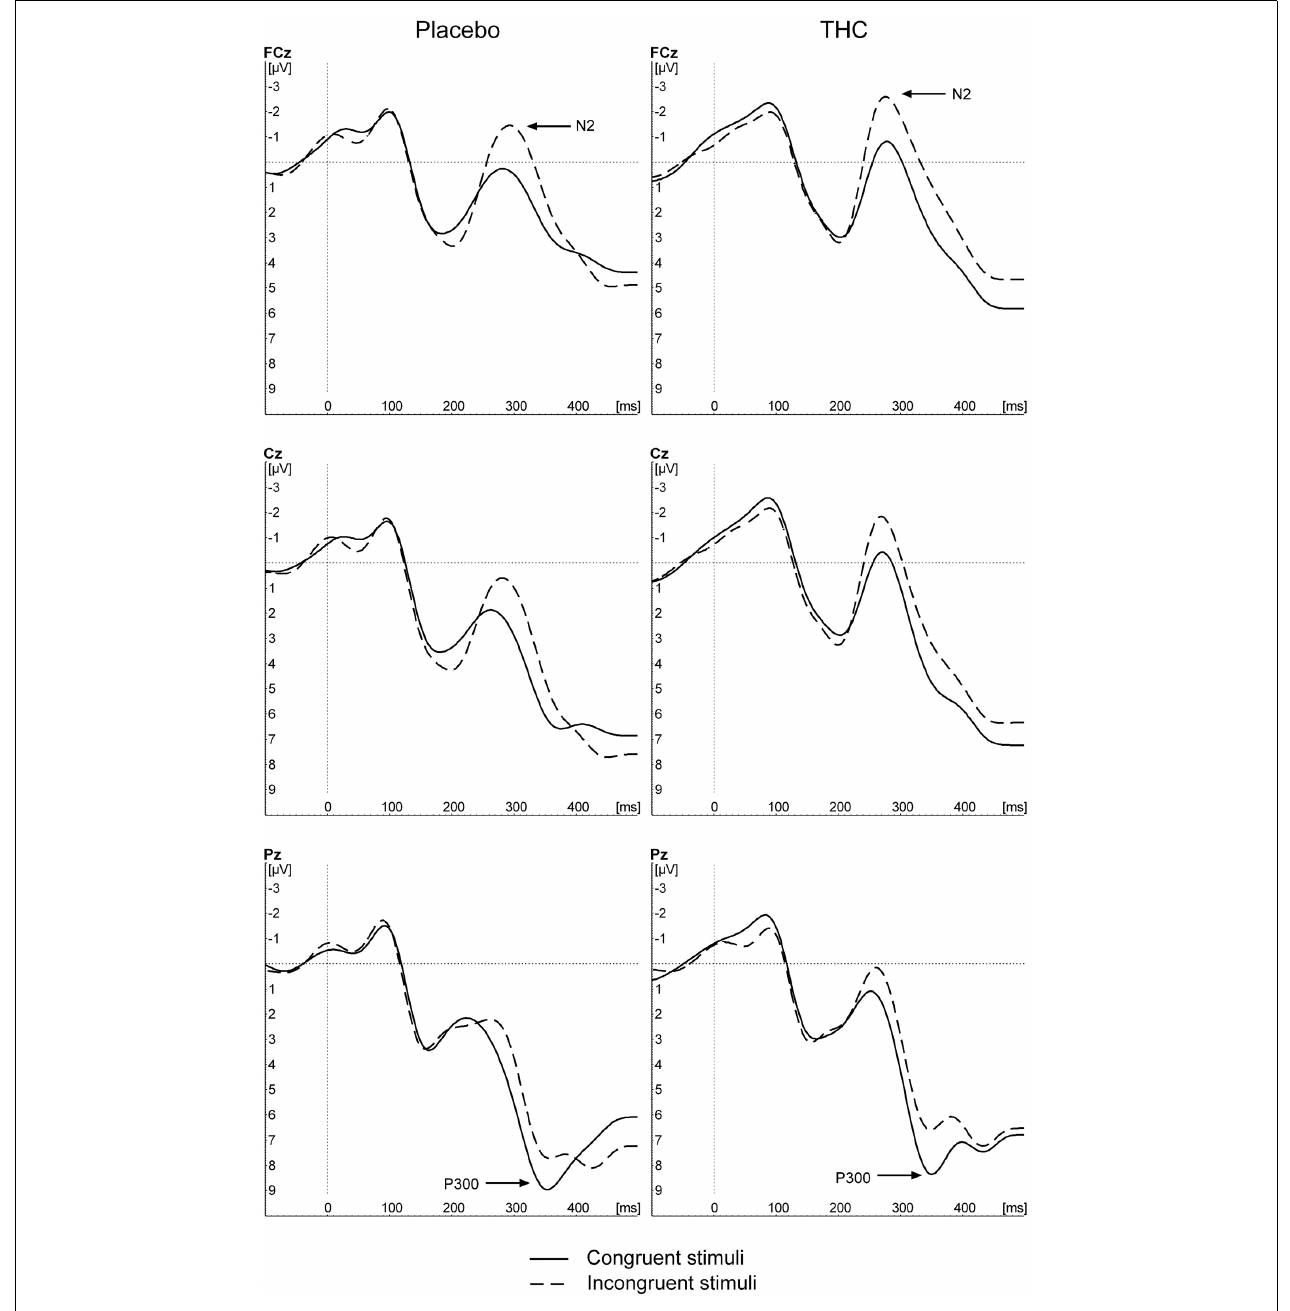
FIGURE 3 | Grand average stimulus-locked waveforms in response to congruent and incongruent trial types for placebo, andTHC